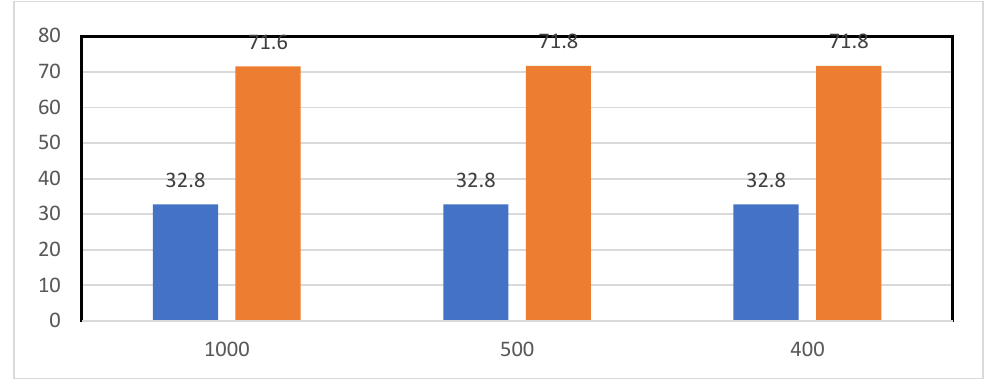
Figure 9. Charging current of solar panel vs dc pump current under various condition of solar